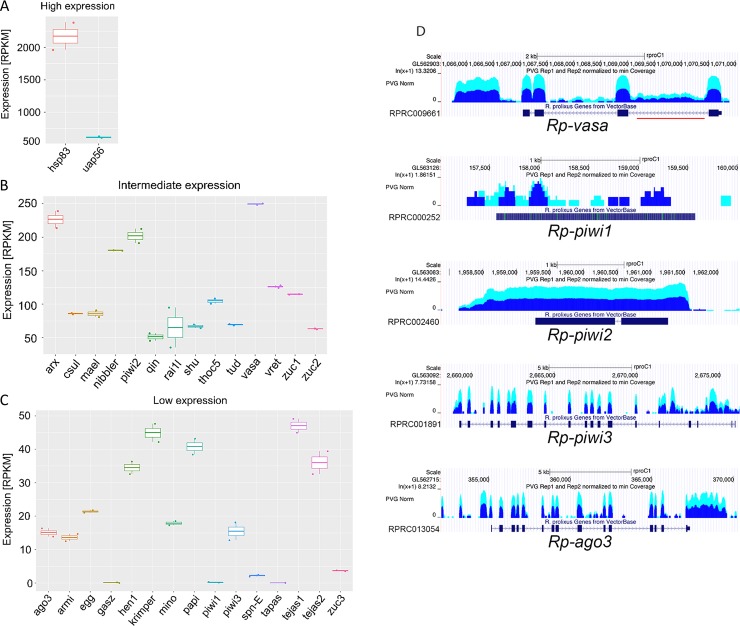
Steady-state expression levels of putative piRNA pathway genes in early Rhodnius oogenesis.A) Box plot showing the highly expressed putative orthologs of the fruit fly uap56 and hsp83 genes in Rhodnius. B) Box plot displaying 14 genes with intermediate expression levels in Rhodnius oogenesis. C) Box plots showing 15 genes, including putative orthologs of spn-E and Rp-piwi1, characterized by low expression levels in Rhodnius. In the panels A-C, Y-axis represents average RPKM values over two biological replicates. D) RNAseq profiles along the Rp-vas, Rp-piwi1, Rp-piwi2, Rp-piwi3 and Rp-ago3 genes. The Y-axis displays RPKM for two biological replicates (dark and light blue). Red line indicates the position of a mariner-like element in the Rp-vas gene. PVG stands for previtellogenic.